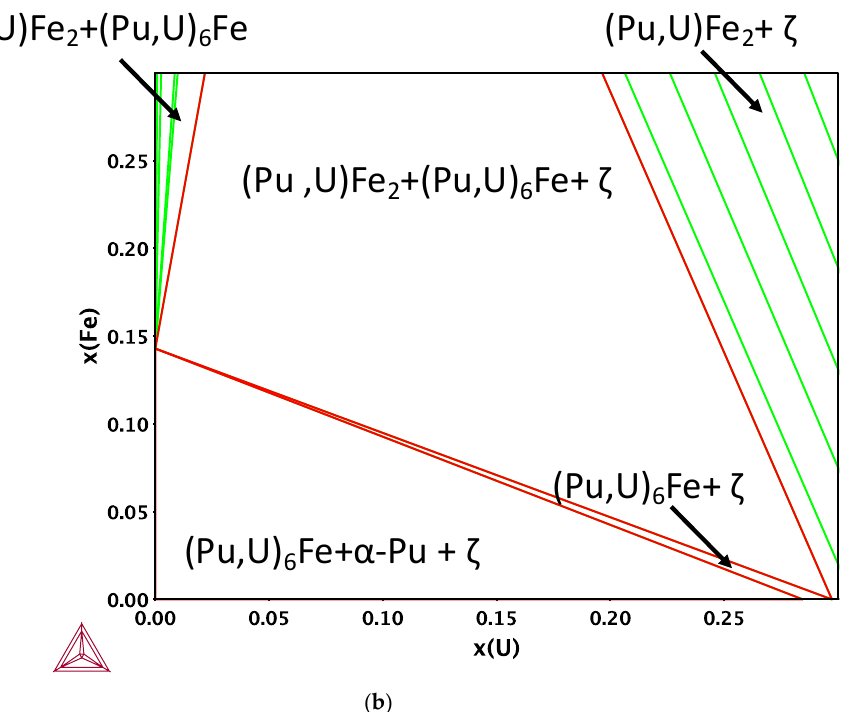
Figure 6. Calculated ( a ) Pu-U-Fe ternary section at room temperature with ( b ) a magnification of the Pu-rich part based on the present CALPHAD assessment.